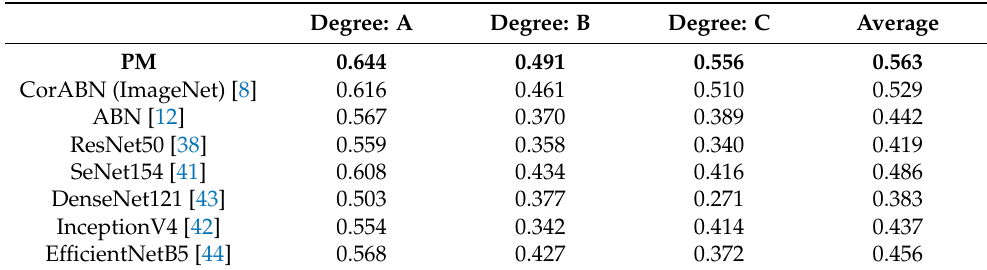
Table 10. F1-scores of PM and CMs in the distress type of concrete spalling. The best scores for each degree and the average are presented in